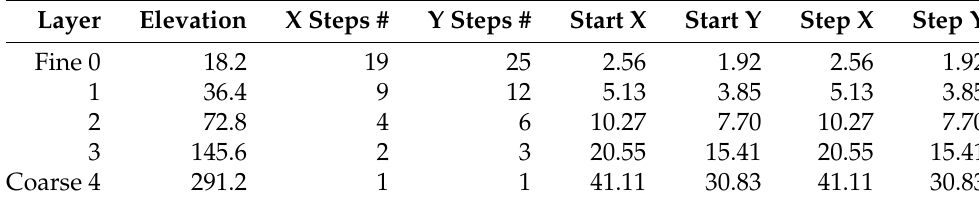
Table 3. Temporal and computational requirements.